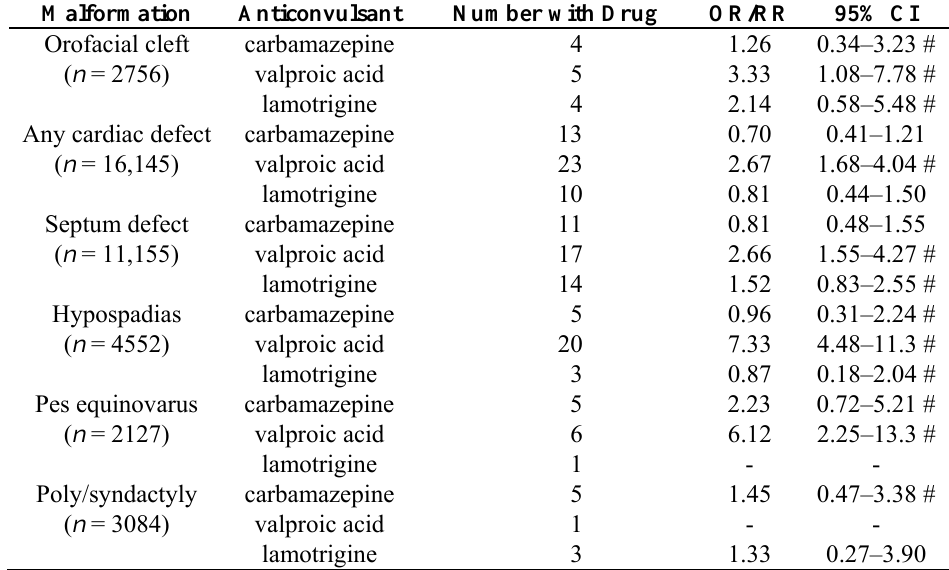
Table 14. Effect of use of three specific anticonvulsants in monotherapy on the occurrence of six groups of malformations. Bold text marks statistical significance. N values mark number of infants in population with this type of